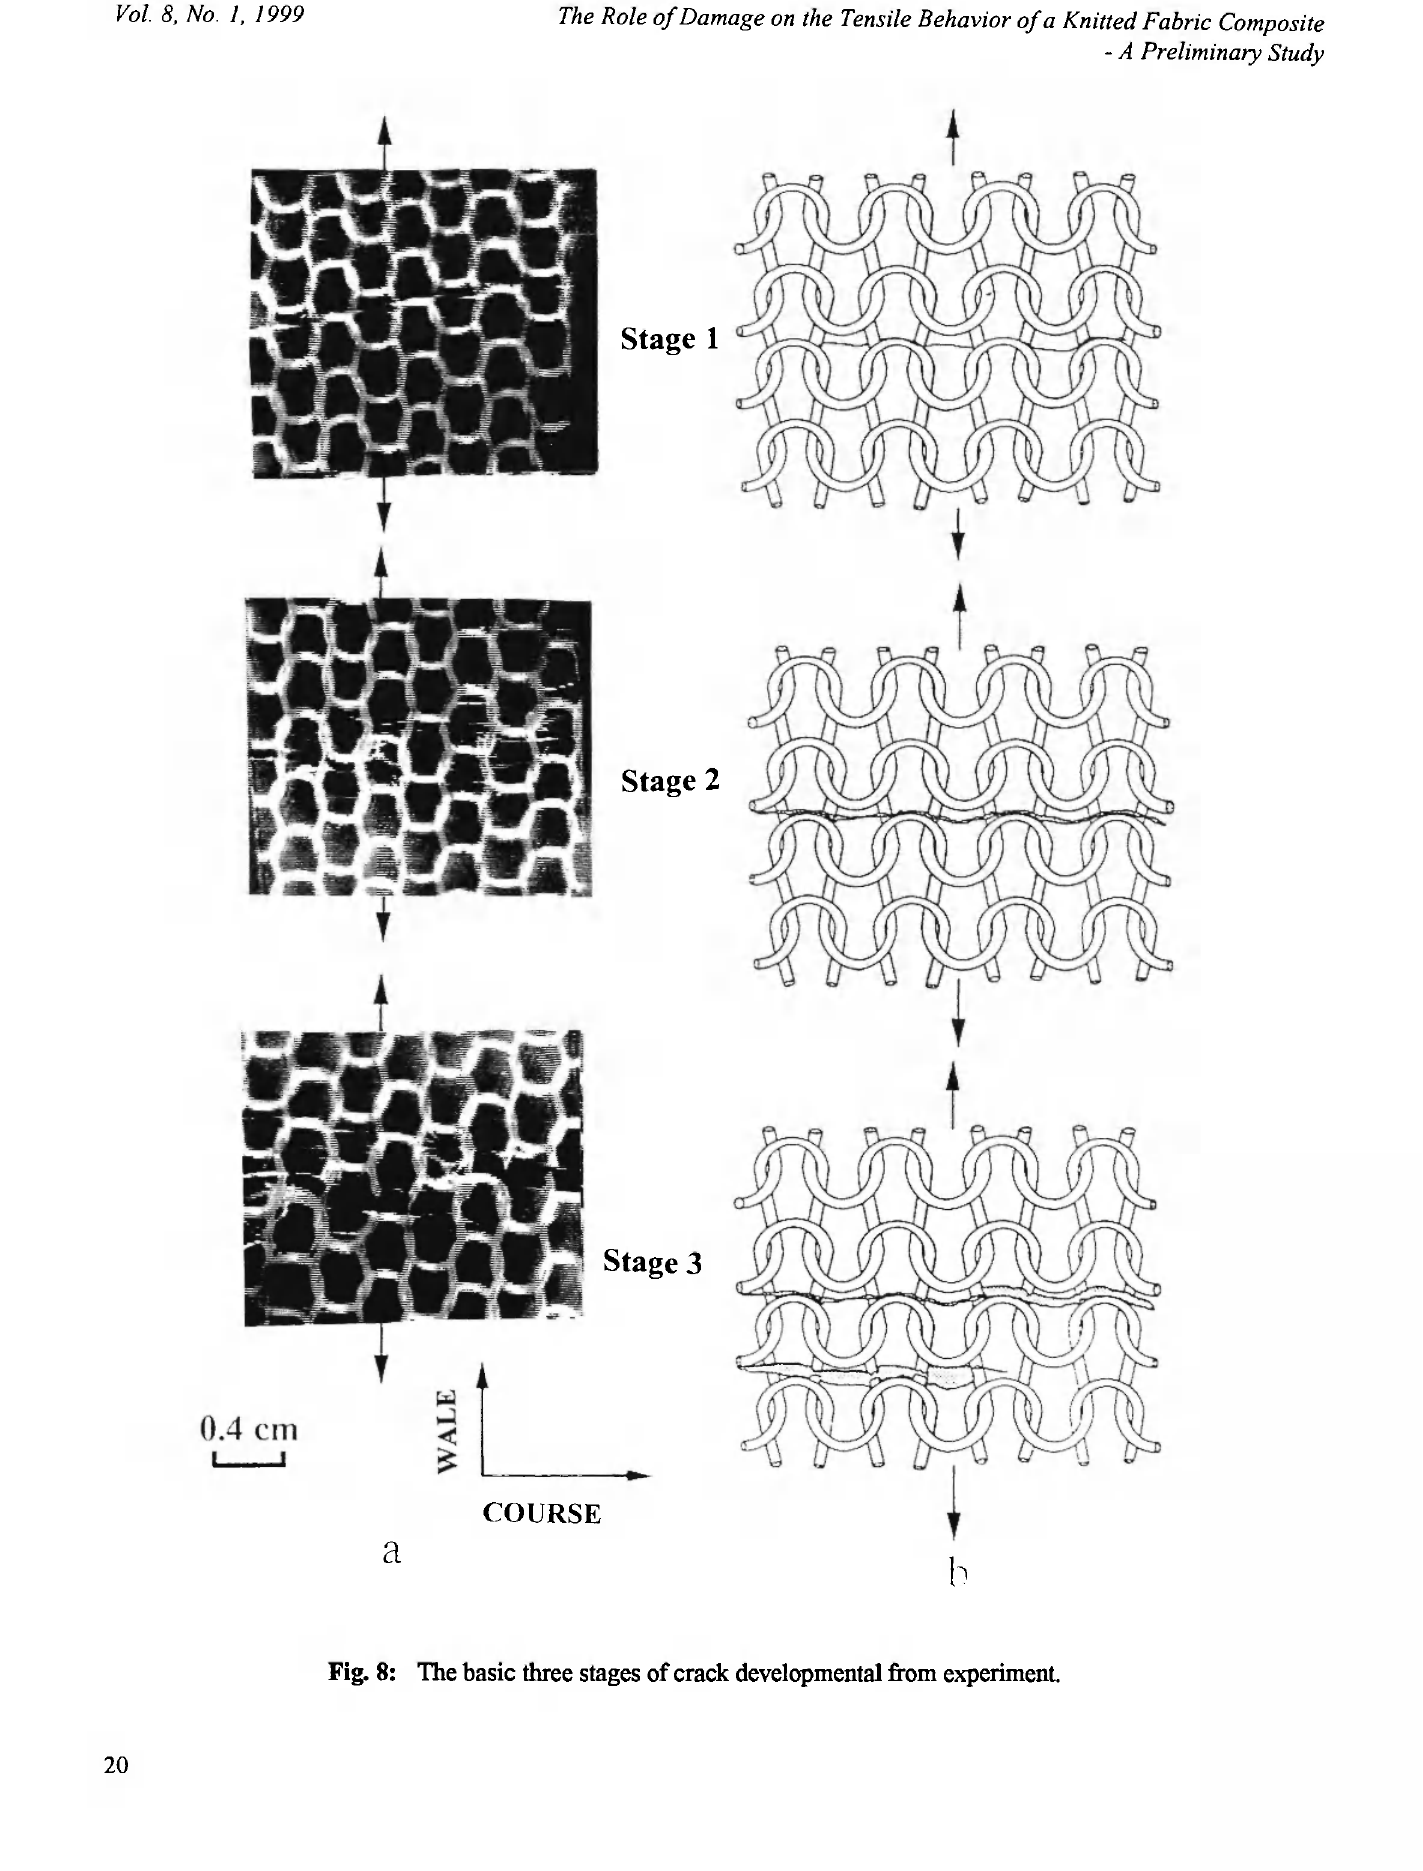
Fig. 8: The basic three stages of crack developmental from